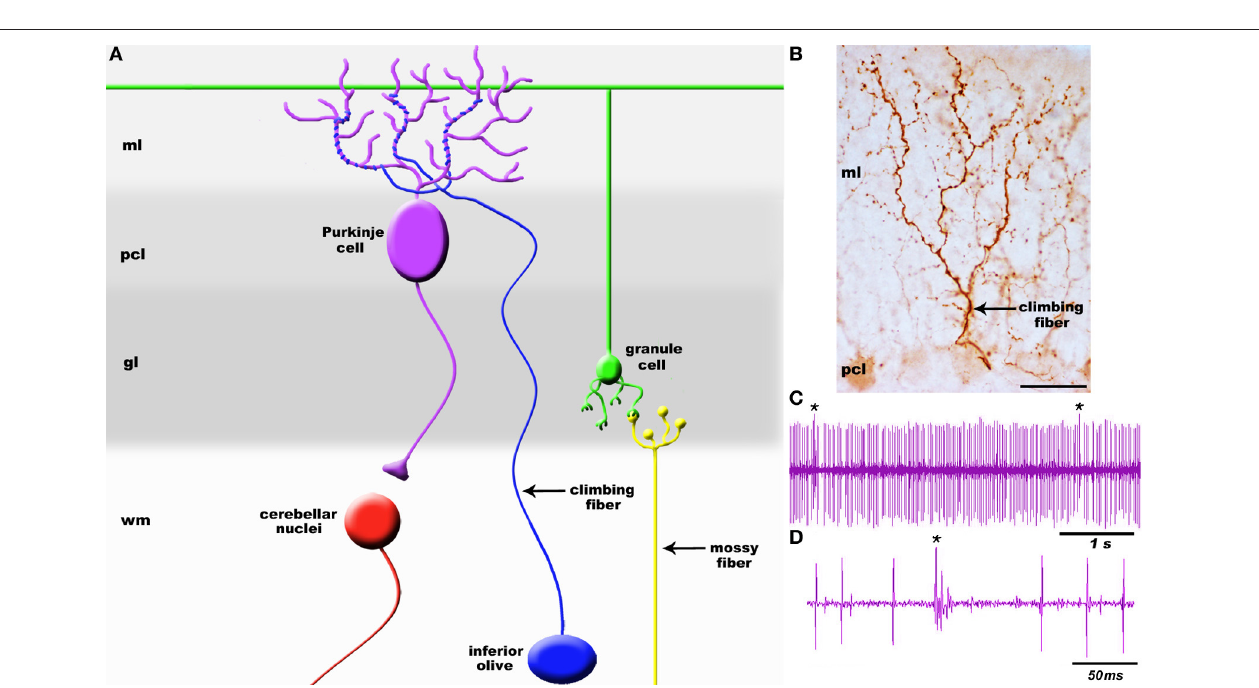
FIGURE 2 | (A) Schematic of a simplified cerebellar microcircuit illustrating the two major sensory afferent pathways that project to the cerebellum: climbing fibers and mossy fibers. Climbing fibers (blue projection) terminate directly onto Purkinje cells whereas mossy fibers (yellow projection) terminate on granule cell dendrites (green). Granule cell axons called parallel fibers contact Purkinje cells (purple). Purkinje cells are the sole output of the cerebellar cortex and transmit signals to the cerebellar nuclei (red). (B) High power image of a climbing fiber expressing cocaine-and amphetamine-regulated transcript (CART) peptide [arrow; staining was performed according to Reeber and Sillitoe (2011)]. The target Purkinje cell is weakly immunoreactive for CART. (C) Example Purkinje cell spike train